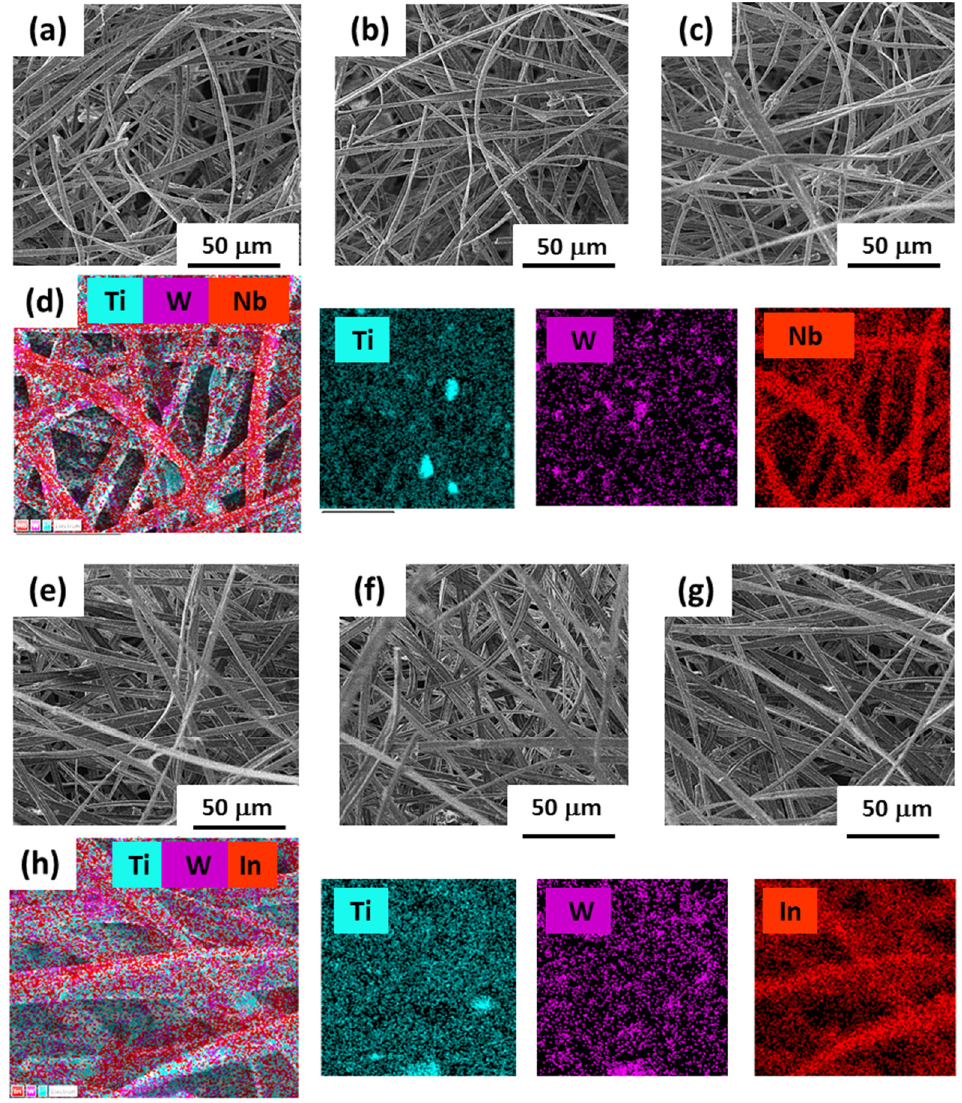
Figure 2. SEM images of electrospun fibers containing TW − Nb MMO with ( a ) 2, ( b ) 4 and ( c ) 6 wt % of Nb 2 O 5 and TW − In MMO with ( e ) 2, ( f ) 4 and ( g ) 6 wt % of In 2 O 3 ; and EDX mappings of ( d ) 𝑇𝑊 − 𝑁𝑏4 and ( h ) 𝑇𝑊 − 𝐼𝑛4 , respectively.